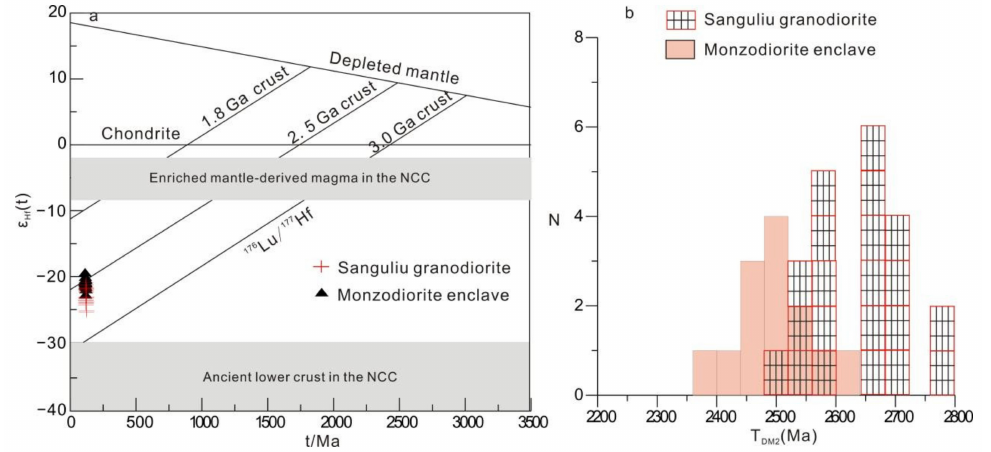
Figure 7. Evolution ε Hf (t) from in situ analysis of zircon Hf versus age (Ma, ( a )) and histogram of T DM2 model ages (Ma, ( b )) of the Sanguliu granodiorite and monzodioritic enclaves. The data of enriched mantle-derived magma and ancient lower crust in the NCC, the Sanguliu granodiorite, as well as enclaves are from [45–47],